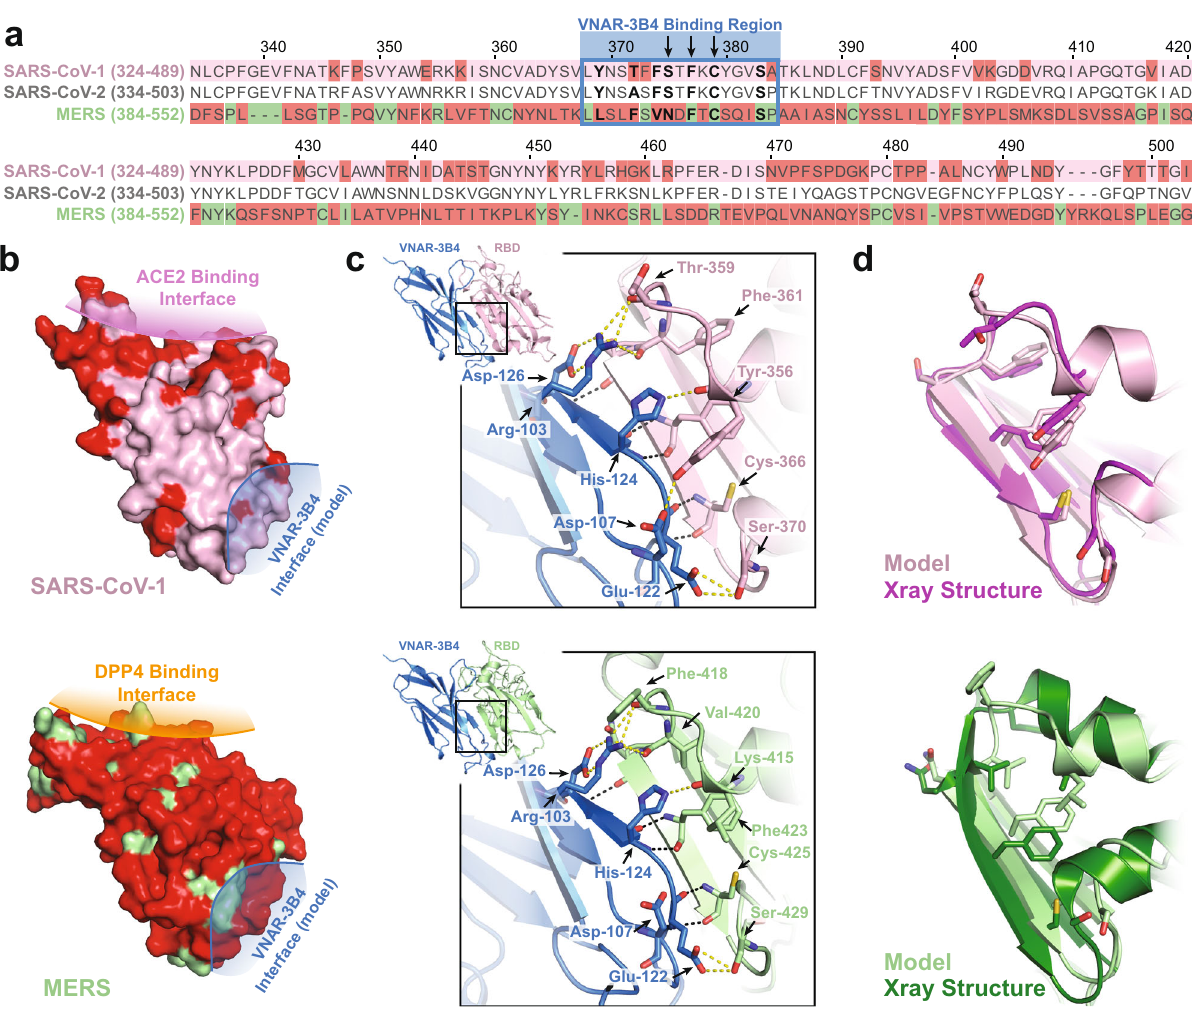
Fig. 5 The VNAR-3B4 epitope is highly conserved between closely-related coronaviruses. a Sequence alignment between SARS-CoV-1, SARS-CoV-2, and the MERS RBDs. Residues different from SARS-CoV-2 are highlighted in red and the interaction interface for VNAR-3B4 is marked with a blue box. Bolded letters indicate residues critical for the interaction between the RBD and 3B4 with arrows indicating the residues that form a backbone beta-sheet. The sequence alignment is numbered above according to SARS-CoV-2. b Surface representations of SARS-CoV-1 (pink, above) and MERS (green, below) with variant residues colored red. The ACE2 binding interface is highlighted in purple for SARS-CoV-1 and the DPP4 binding interface in orange for MERS. The homology-modeled interaction interface for 3B4 is colored blue for both structures. c Zoomed in view of the modeled interaction interface between 3B4 (blue) and SARS-CoV-1 (pink, above) and MERS (green, below), with 3B4 colored blue in both pictures. Interacting residues are highlighted as in Fig. 2, showing the backbone interactions in black dashes and sidechain to backbone or sidechain to sidechain interactions shown as yellow dashes. Insets show the orientation of the zoomed in view. d Overlays of the 3B4 interface from modeled RBDs and their matching RBDs obtained by x-ray crystallography. The panel above shows the modeled SARS-CoV-1 RBD, colored pink, aligned with the crystal structure of SARS-CoV-1 RBD bound to ACE2 (PDB id: 2AJF), colored magenta. The panel below shows the modeled MERS RBD, colored light green, aligned with the crystal structure of MERS RBD bound to DPP4 (PDB id: 4L72), colored dark